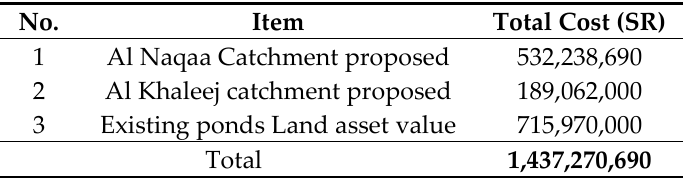
Table A3. Total cost of pond system.